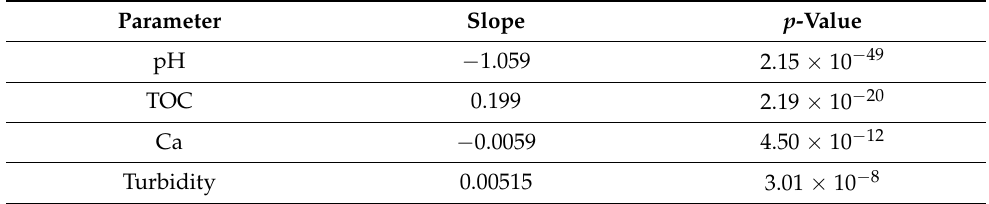
Table 3. Slope and p -values from maximum likelihood regression models of relationships between Al concentration and other water chemistry parameters.